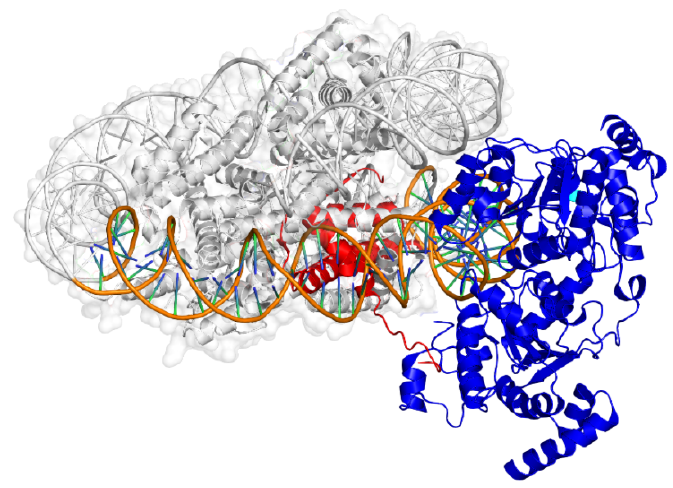
Figure 4. The ternary complex of STH1 / NPS1 nuclear protein (blue cartoon), a histone reader, the DNA (orange cartoon), wrapped around the nucleosome and histone H4 (red cartoon), that is buried in the nucleosome. The non-interacting parts are represented in grey cartoon. The figure was rendered by PyMol [47] using PDB structure 6tda [94].